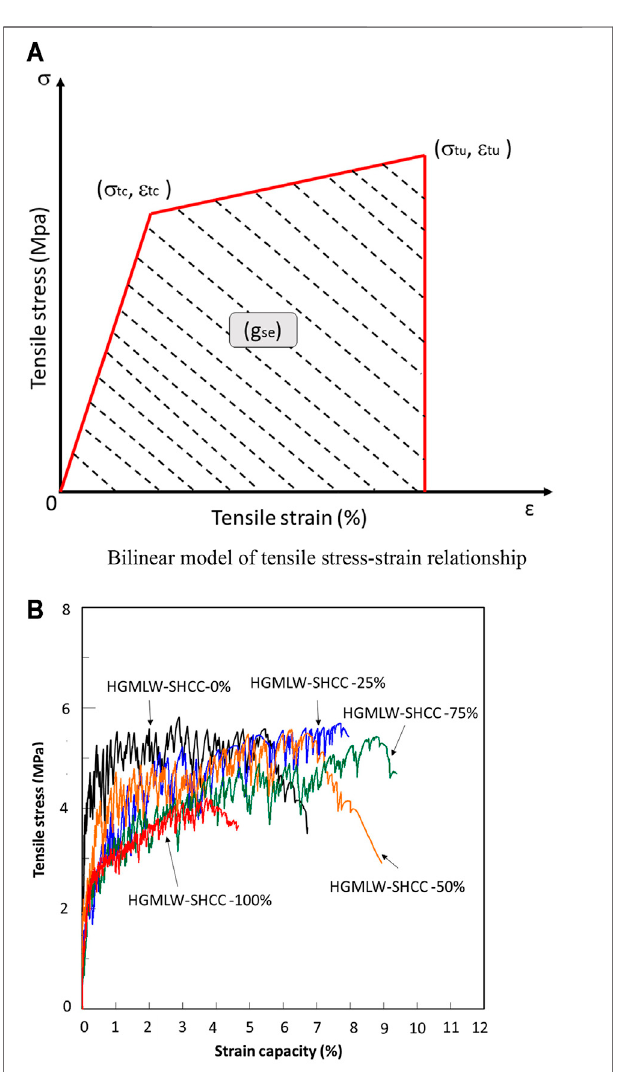
FIGURE 5 | (A) Bilinear model of tensile stress-strain relationship. (B) Average results of tensile stress-strain curves of